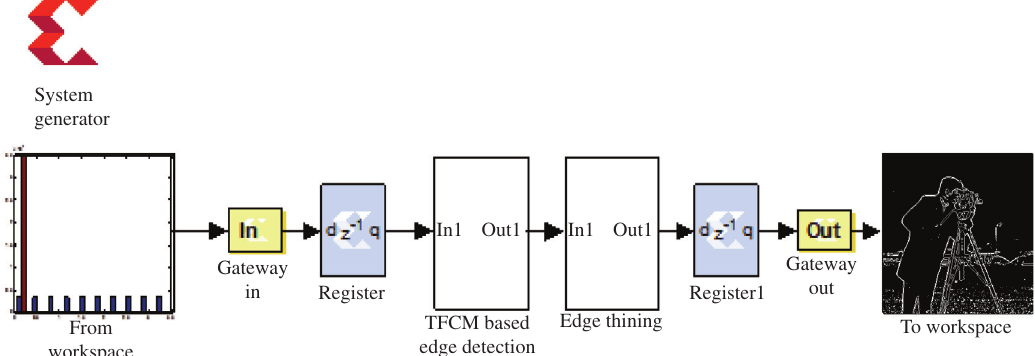
Figure 9. Block Diagram of the Proposed TFCM-Based Edge Detection